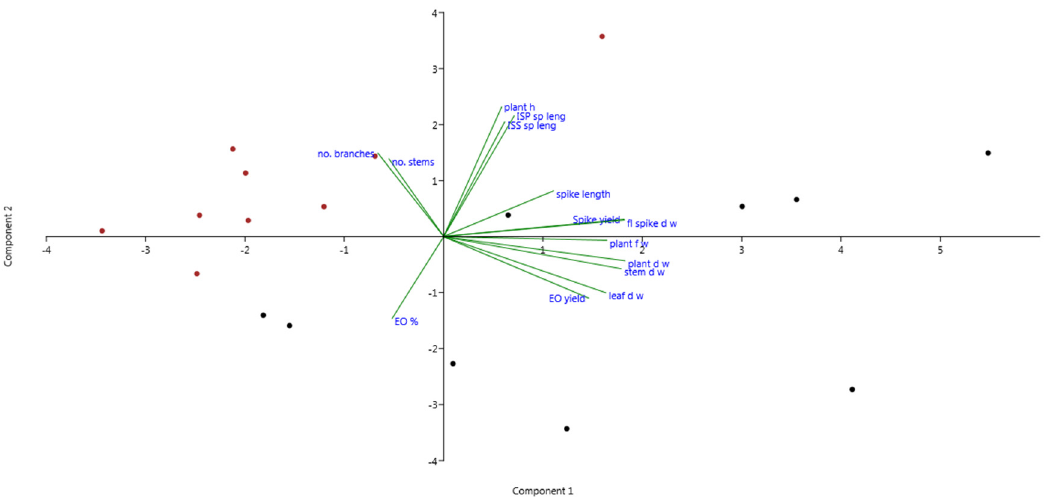
Figure 4. Loading plot of the factor weights pertaining to the main two Principal Component. In the graph, black points refer to clary sage accessions cultivated in the first year while red points refer to accessions cultivated in the second year.